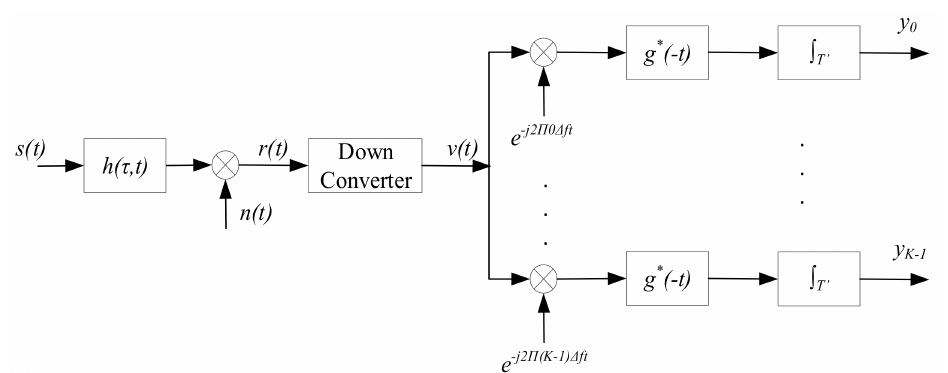
Figure 4. Block diagram of OFDM transmitter [76].